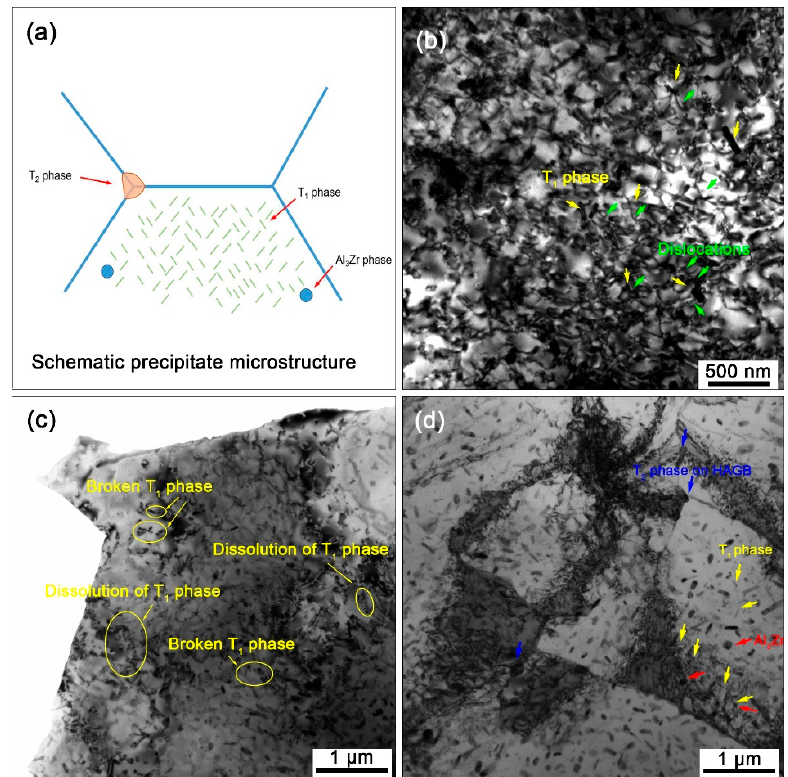
Figure 10. ( a ) Schematic precipitate microstructure of the compressed samples; ( b ) strong interaction between dislocation and T 1 phase in sample at 320 °C/0.001 s − 1 ; ( c ) fracture and dissolution of T 1 phase in sample at 380 °C/0.001 s − 1 ; ( d ) the BF TEM image of representative precipitates in compressed sample at 320 °C/0.001 s − 1 .